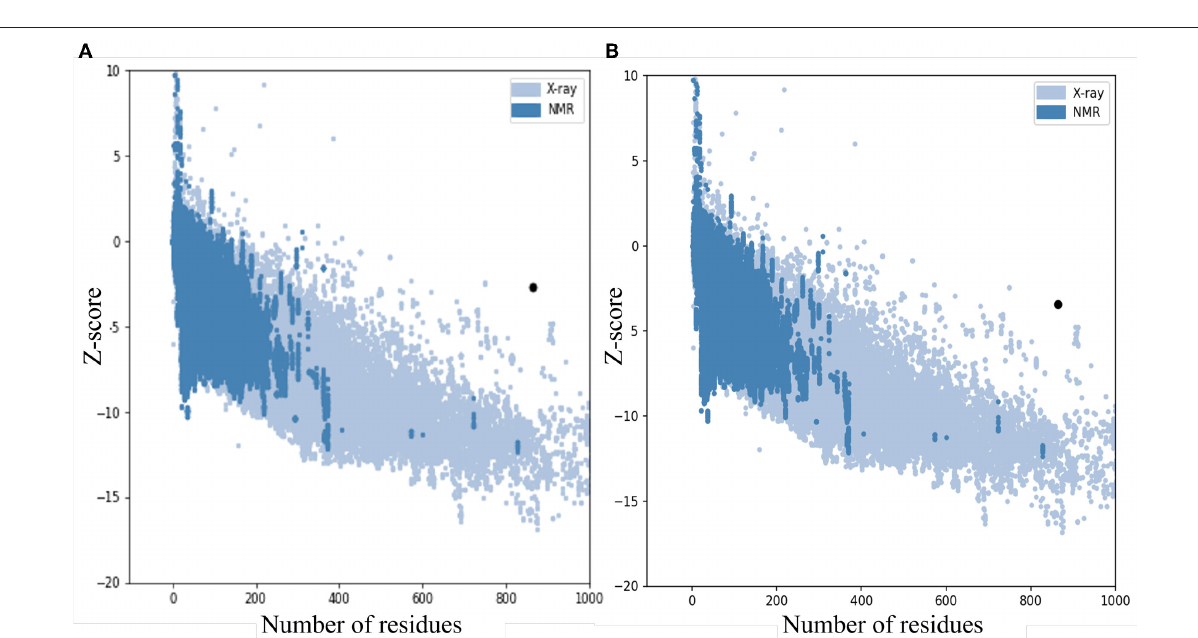
FIGURE 5 | Z -Score plot for the 3D structure of the final vaccine. The Z -score of (A) the initial model is 2.81 and (B) The z -score of the refined model is 3.64, both of two models not in the range of native protein conformation. Z -Score plot contains z -scores of all experimental protein chains in PDB determined by NMR spectroscopy (dark blue) and X-ray crystallography (light